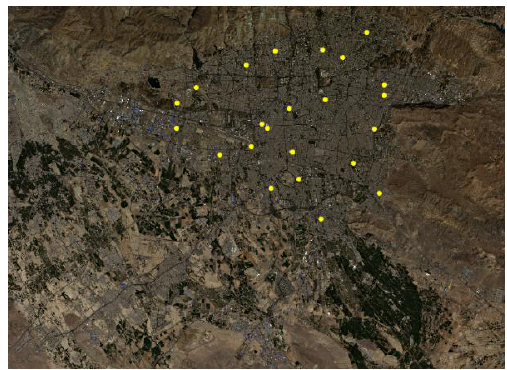
Figure2. study area and station